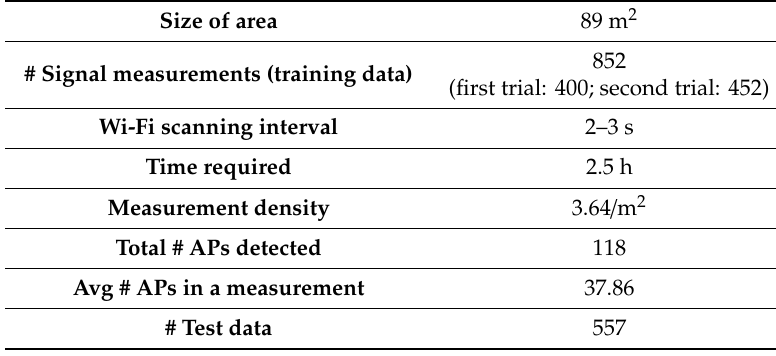
Table 2. Experimental environment and data collection specifications. APs: access points.